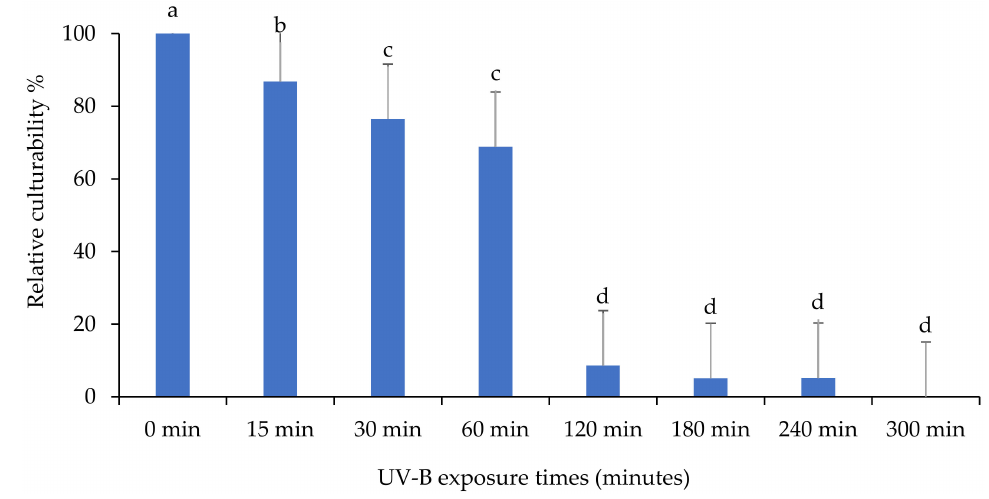
Figure 4. The impact of different UV-B exposure times on relative culturability percentage of Beauveria bassiana isolate “BbSA-3”. The mean number of relative culturability percentage ± SE is shown. Different letters on the same patterned bars indicate significant differences (LSD test, p < 0.05).